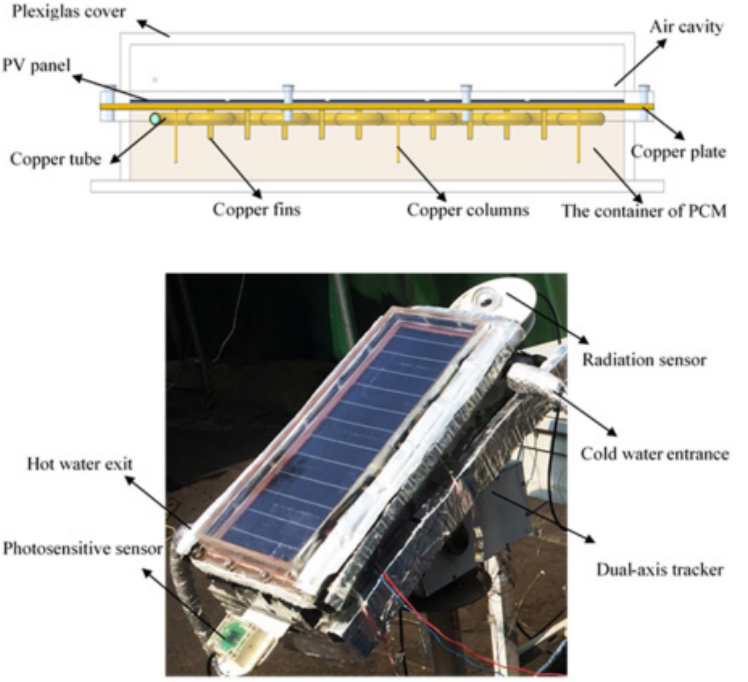
Figure 14. Diagram of the experimental setup studied by Xu et al. [42]. Adapted with permission from Elsevier. from